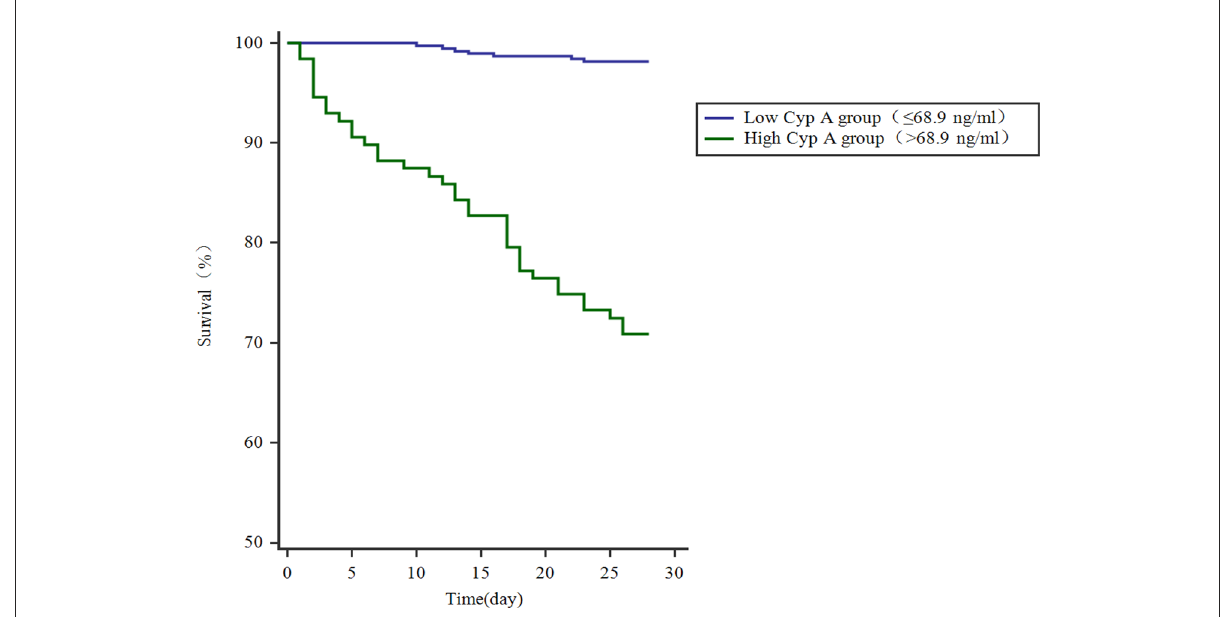
FIGURE3 Kaplan-meier plot showing survival in craniocerebral trauma patients grouped by Cyp A levels.